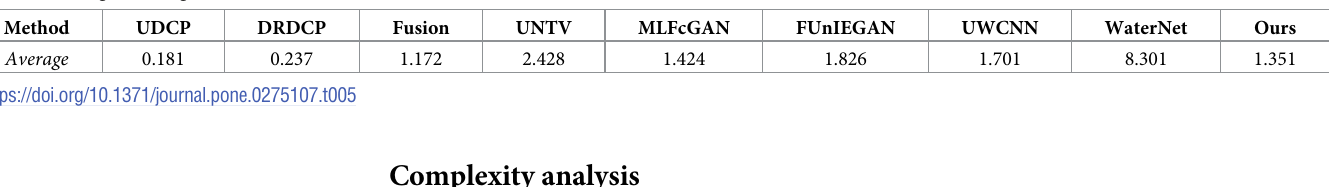
Table 5. Average running time